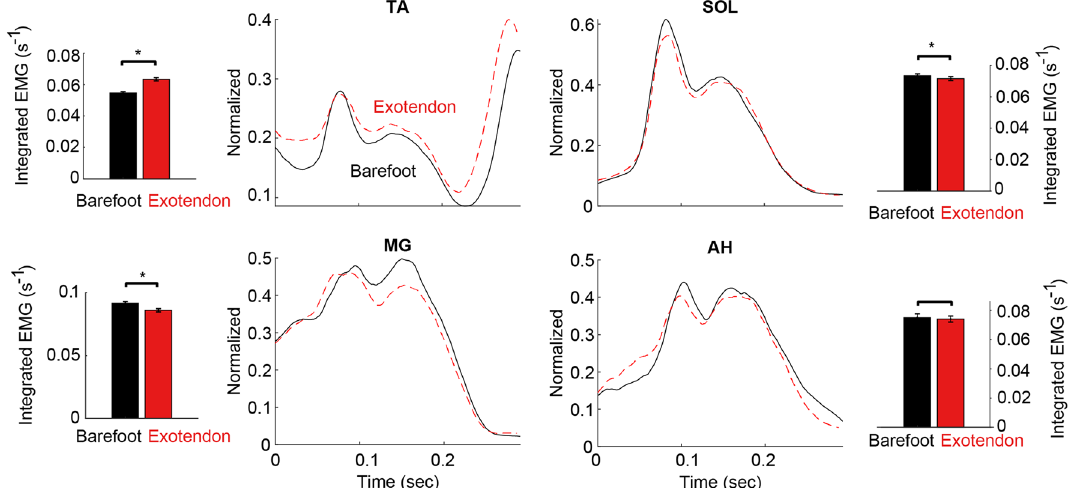
Figure 4. Electromyography data of four foot–ankle muscles during stance phase of hopping at 140 Hz averaged across all participants. Data are rectified, bandpass filtered, filtered with a moving RMS window, and normalized to the average of the top 10 peak activations of each muscle while running at 3 m/s on a per- participant basis. The continuous time plots show the activation patterns of each muscle during the contact phase of a hopping cycle, comparing barefoot (black line) to the exotendon (dashed red). The exotendon tended to decrease peak activation of the foot muscle AH and ankle plantarflexors (MG and SOL), whereas it tended to increase the mean activation of the ankle dorsiflexor TA across the entire cycle. Additionally, integrated activation levels are shown as bar plots adjacent to each of the time series plots, with an asterisk denoting significance between barefoot and exotendon data as estimated by the linear mixed effects model.